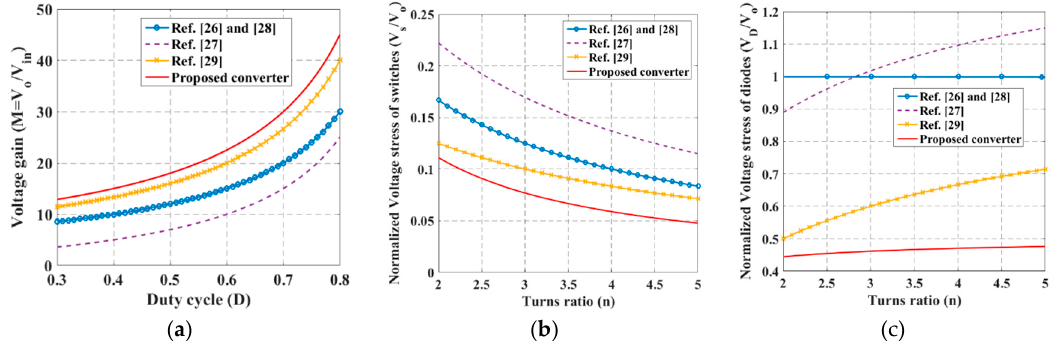
Figure 7. Comparison between the proposed converter and other step-up converters. ( a ) Voltage gain versus duty cycle (D) when n = 2; ( b ) voltage stress of switches versus turns ratio (n); and ( c ) voltage stress of diodes versus turns ratio (n).